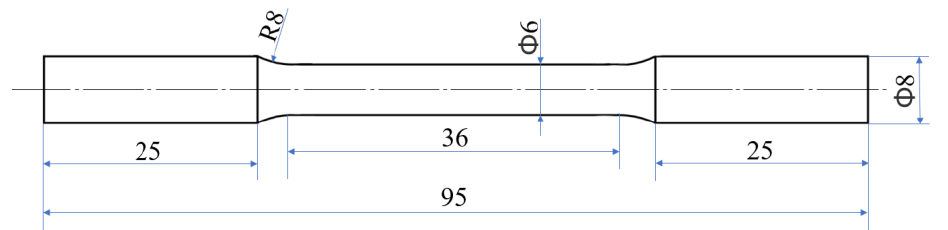
Figure 5. The specific shape and size of tensile test samples.